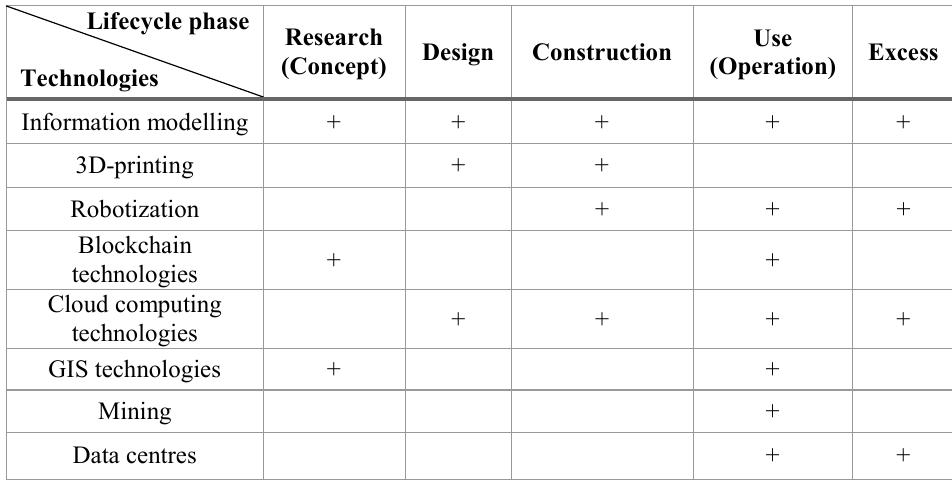
Table 1. Application of Digital Technologies at Different Stages of a Real Estate Asset Lifecycle (developed by the